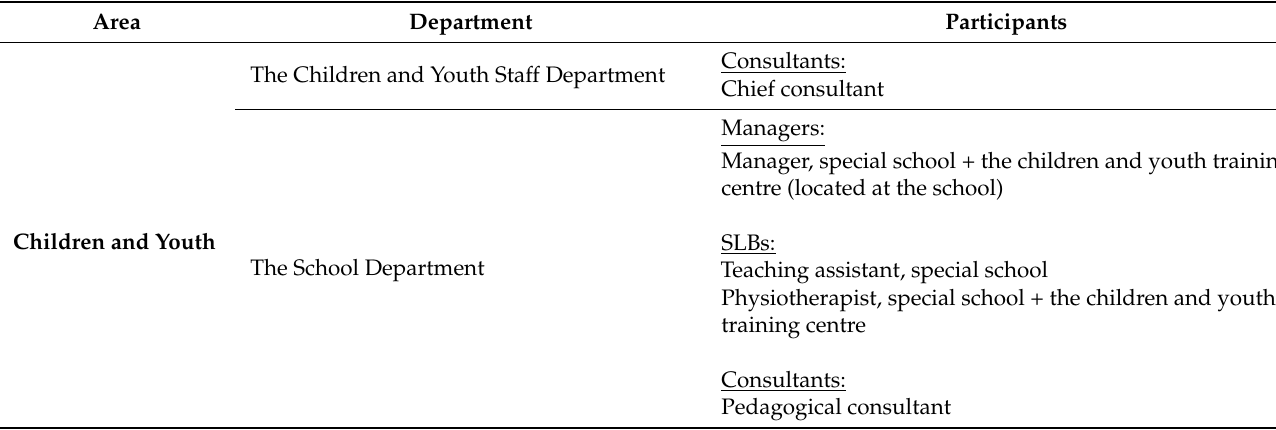
Table 2. Participants, Municipality 2